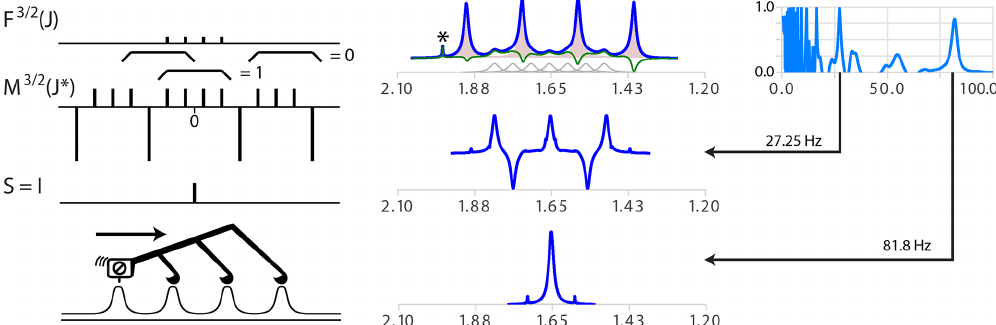
Figure 6. (Top right) Model multiplet structure for coupling with S = 3 / 2 partners. (Middle right) Simplifying series of δ functions M 3 / 2 ( J ∗ ). The braces show examples of integration regions and illustrate that it is zero for all positions except the central one. The side-to- side process is quite similar to the case of S = 1 / 2 except that subtraction of the cursor position has to be made to the n − 1 positions located J ∗ further in the data array. (Centre) Analysis of the proton spectrum of BH + . Specifying the spin of the partner as 3 / 2 replaces the wrong 4 assignment dd ( J = 163.6, 81.6Hz, not shown) with the correct 1 : 1 : 1 : 1 quartet with J = 81.6Hz (bottom centre). The extremum of the quality function (right) for J ∗ = J/ 3 = 27.25 is due to a non-simplified but symmetric structure (bottom centre). The presence of the minor multiplet for the 10 B isotope (20% natural abundance, S = 3, seven transitions) with a γ one-third that of 11 B is highlighted in grey in the top subplot. Note that the artifact (probably traces of acetone highlighted by a star symbol) was scaled down by